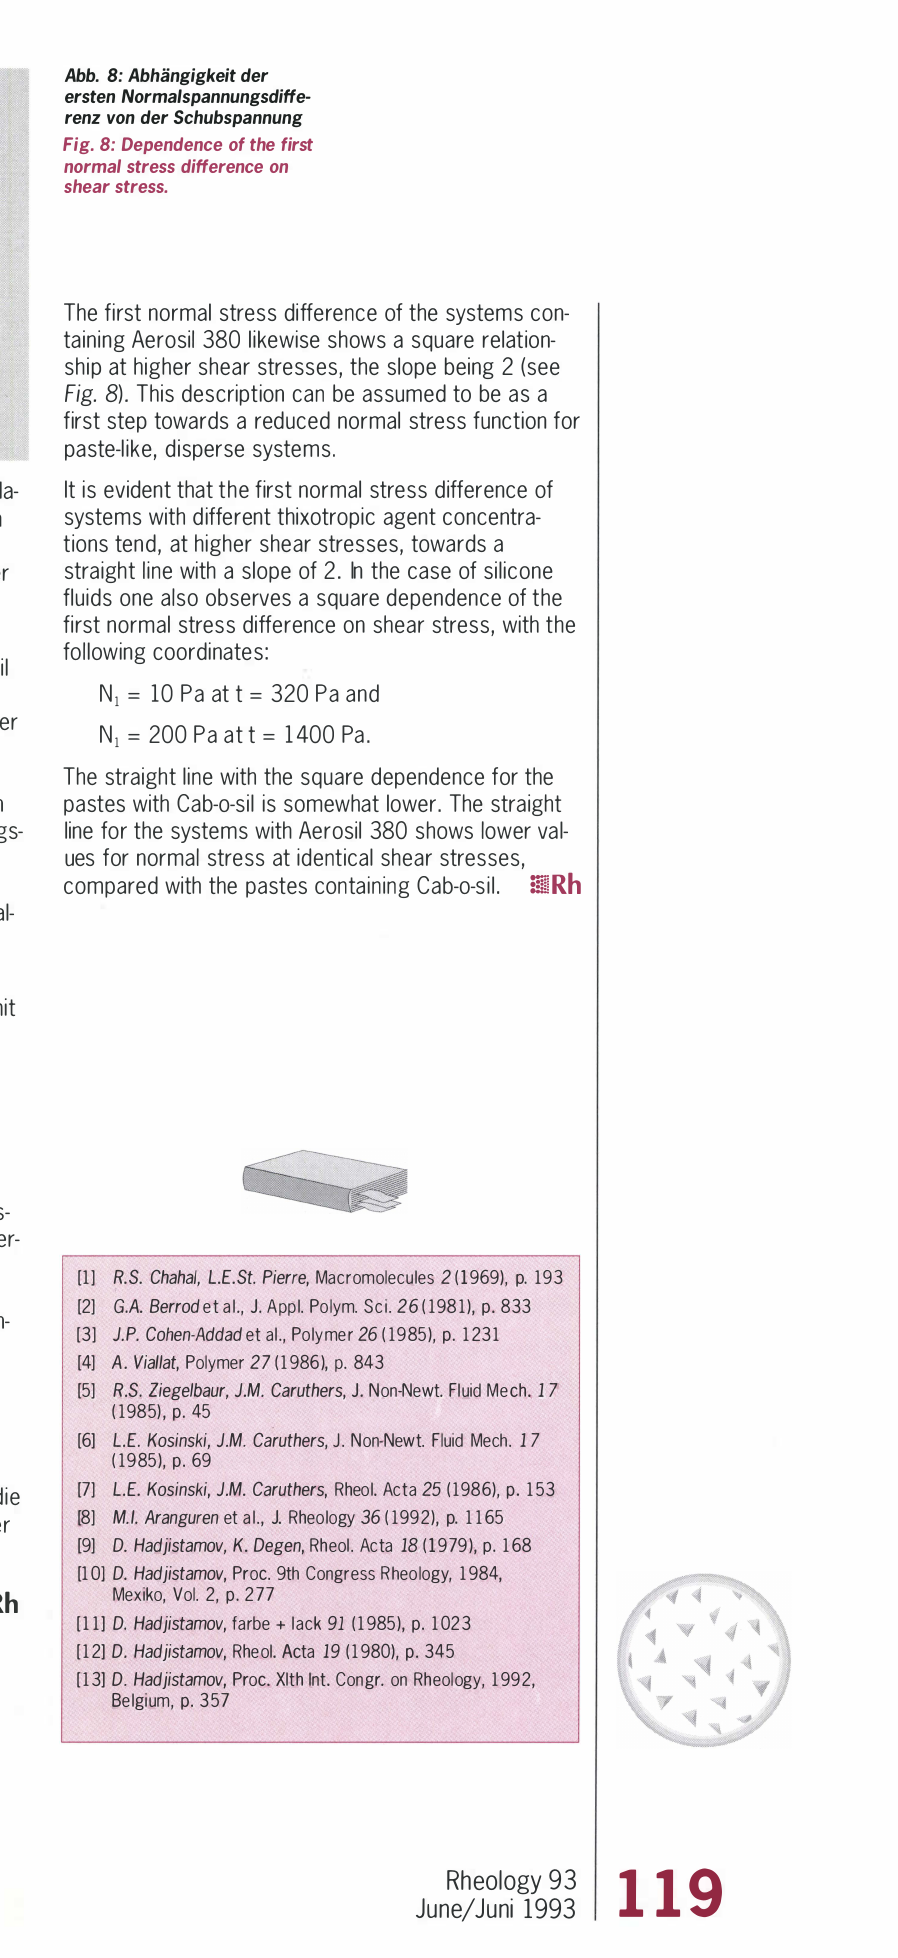
Fig. 8: Dependence of the first normal stress difference on shear stress.